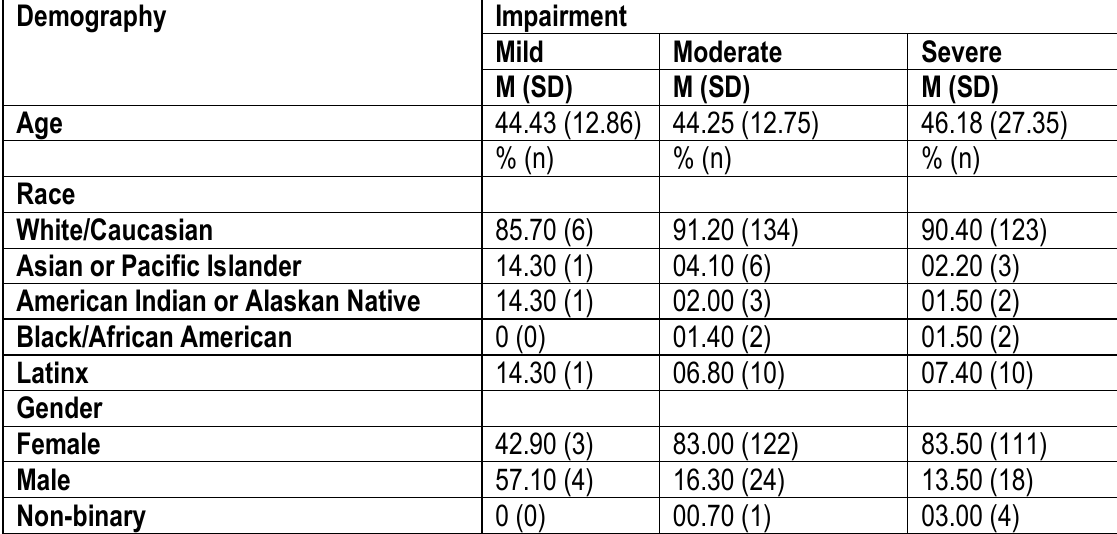
Table 2. Demographic statistics across the three impairment